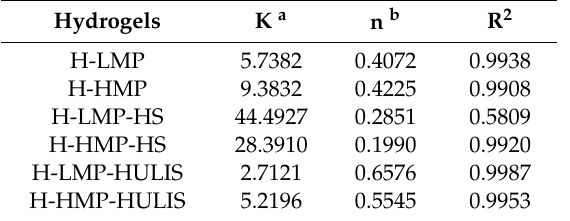
Table 2. Kinetic parameters of phloroglucinol released from hydrogels using the Korsmeyer-Peppas model.